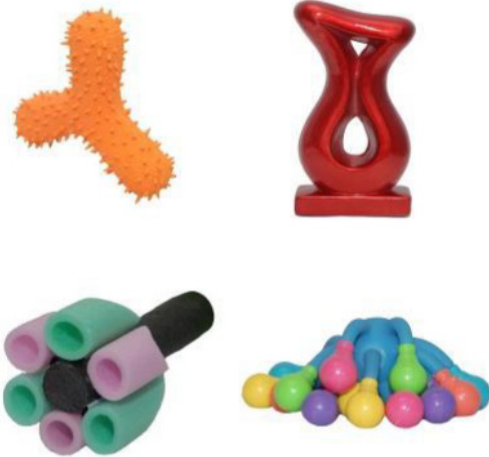
Figure 3. Display Layout in the Retention Tests for the Four Novel Objects.